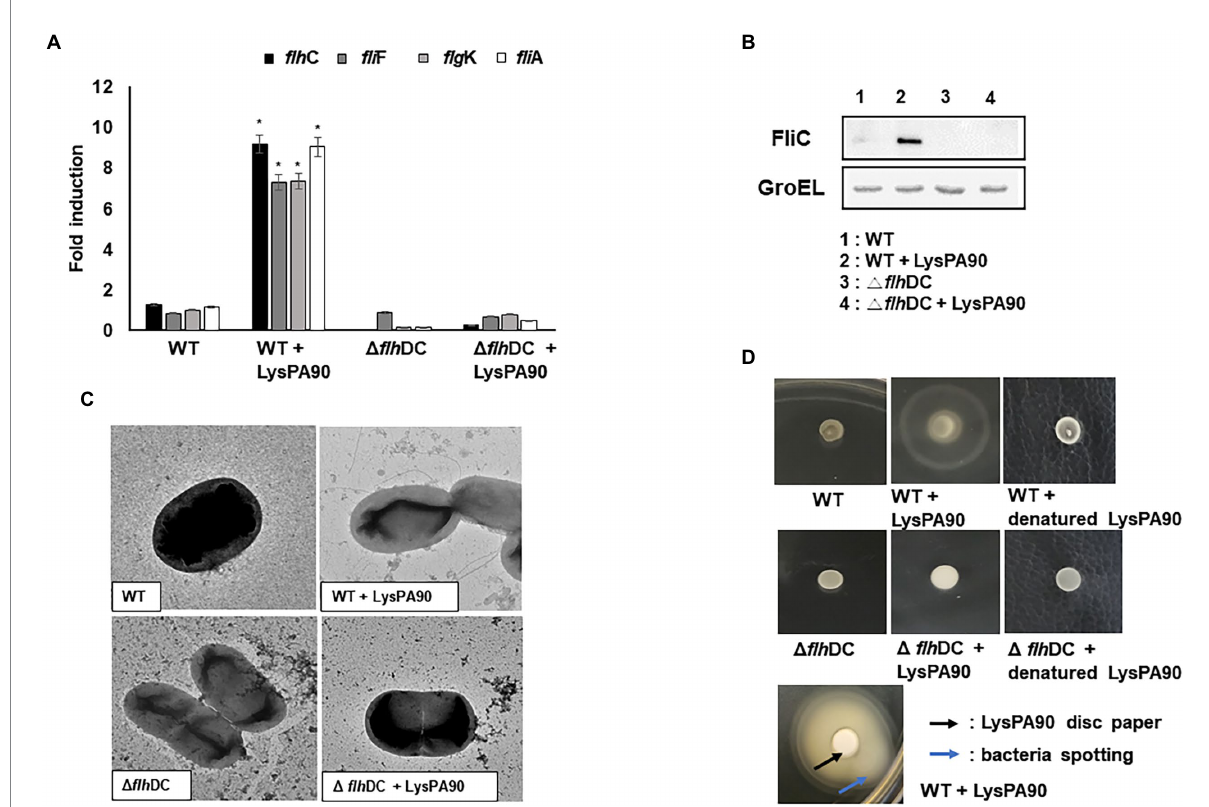
FIGURE 3 Upregulation of genes related to flagella biosynthesis and resulting phenotypical changes. (A) Realtime RT-PCR of genes related to flagella biosynthesis. Total RNA from wildtype (WT) or flh DC deletion mutant ( Δ flh DC) strains were isolated with or without stimulation of the endolysin LysPA90. flh C, flagellar transcriptional regulator (Class I); fli A, flagella-specific sigma factor (Class II); flg F, flagella basal body rod protein (Class II), and flg K, flagella hook-associated protein (Class III). Experiments were performed in triplicate. Data are expressed as mean ± standard deviation. (B) Western blot analysis of FliC, flagellin protein (Class III) expression. GroEL was used as an internal control. (C) Transmission electron microscopic observation of flagella expression. Note that multi-flagella structure was seen only from the wildtype strain in the presence of LysPA90. (D) Observation of swarming motilities. Wild type (WT) or flh DC mutant strains ( Δ flh DC) were spotted with or without preincubation with LysPA90 or denatured LysPA90 (top two rows). Wild type strain preincubated with LysPA90 was spotted next to a disc soaked in a solution containing 14.7 mg/ml of LysPA90 (bottom row). The latter plate was incubated longer than the former to see the halo extending beyond the